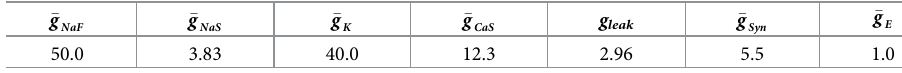
Table 1. Canonical conductance parameters and perturbation conductance (in nS).